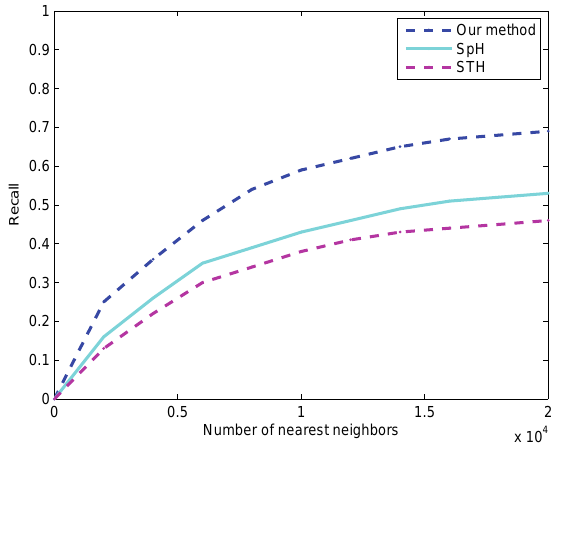
Fig. 3. Nearest neibhor search performance of hashing methods on GIST1M.